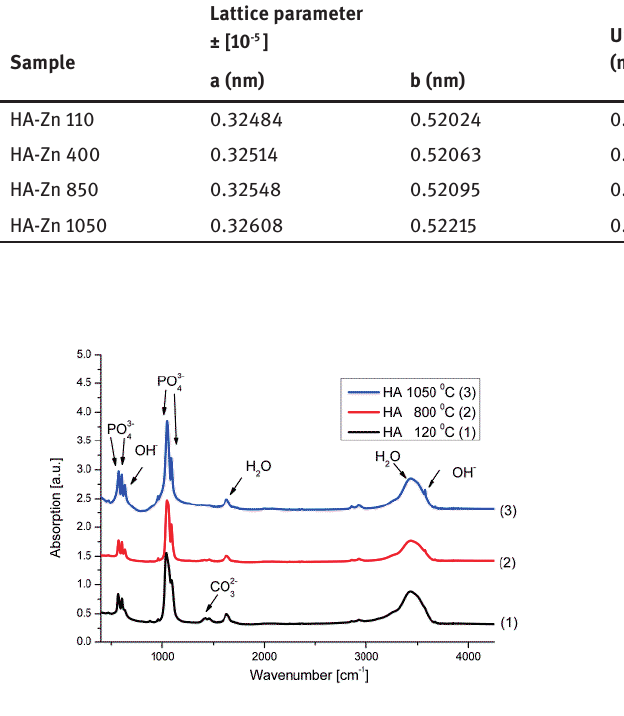
Figure 4: FT-IR spectra of